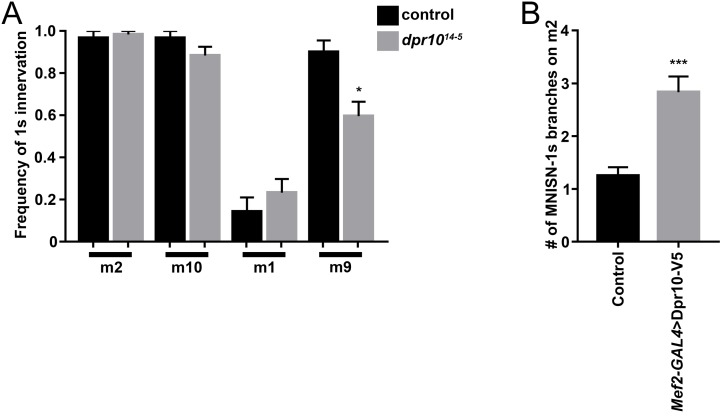
MNISN-1s innervation of dorsal muscles and branching on m2.(A) Frequency of MNISN-1s innervation of dorsal muscles from control (w1118) and dpr10 mutants. (B) Quantification of MNISN-1s branches on m2 in control (UAS-Dpr10/+) and muscle overexpressedDpr10-V5. n (animals/hemisegments) = (A) (7/30), (7/32) and (B) (6/30), (12/62) (respectively). Error bars represent SEM. *p<0.05, ***p<0.0001. See also Figure 6.